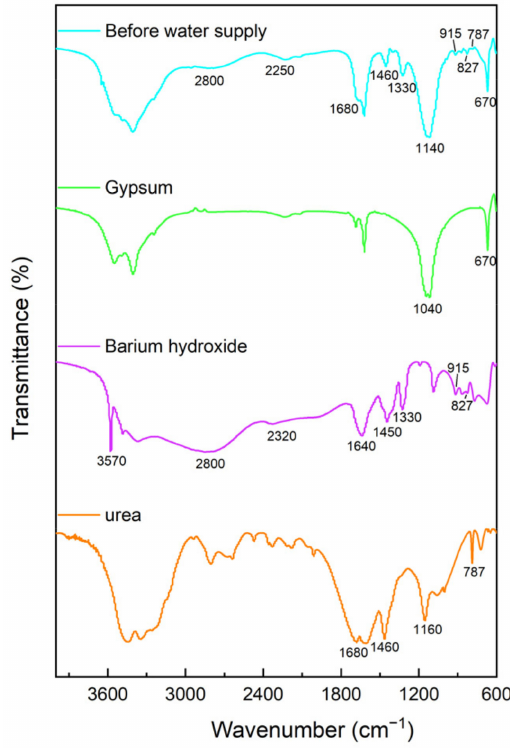
Figure 4. FTIR spectra of the specimen before the water supply.